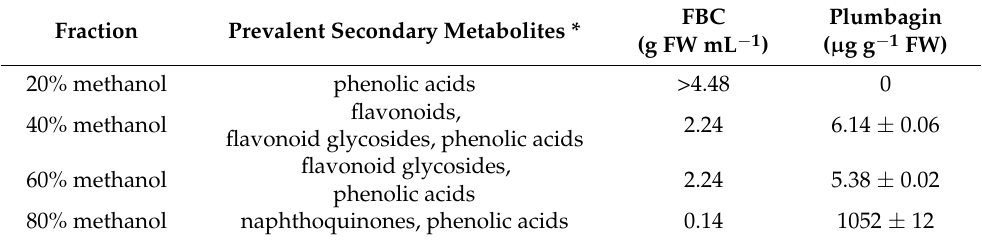
Table 5. Composition and bactericidal potential of fractions from D. muscipula tetrahydrofuran extract obtained in methanol gradient in water (20%, 40%, 60% and 80%) combined with silver nanoparticles towards Pseudomonas aeruginosa ATCC 27853.